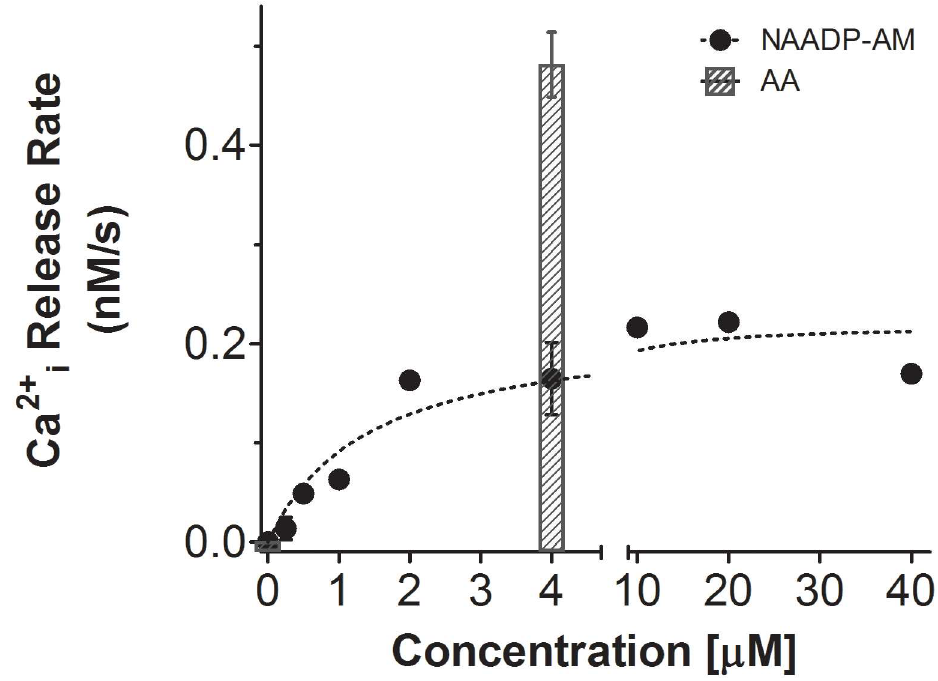
Fig 6. Dose-response curve of NAADP-AM on [Ca 2+ ]i increaserate. Dose-response curve of NAADP-AM releasable intracellularCa 2+ vs NAADP-AM extracellular concentration. Cells were loadedwith fura-2 and incubatedin KH-lactate-EGTA media without added Ca 2+ at 33˚C. As a reference, the effect of 4 μ M AA is shown as a bar. Each point represents the data obtained from three different cell preparations (N =